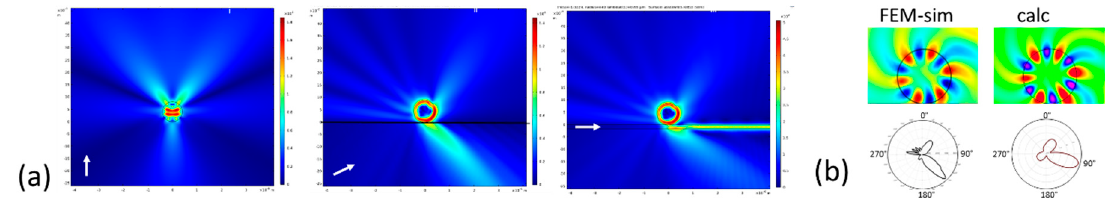
Figure 1. Scattering from a particle with r = 440 nm. ( a ) The absolute value of the scattered electric field is plotted for three different scattering scenarios: (i) particle exposed to a plane wave in air, (ii) particle exposed to the evanescent field of a plane wave, which undergoes total internal reflection at an interface, and (iii) particle exposed to the evanescent field of a guided mode in a waveguide. Arrows indicate the direction of the incoming wave. ( b ) Comparison of simulation with analytical calculation for near-field (upper row) and far-field (lower row): for the near field the real value of the scattered electric field is plotted and polar plots display the angular dependence of the electric field amplitude in the far field.